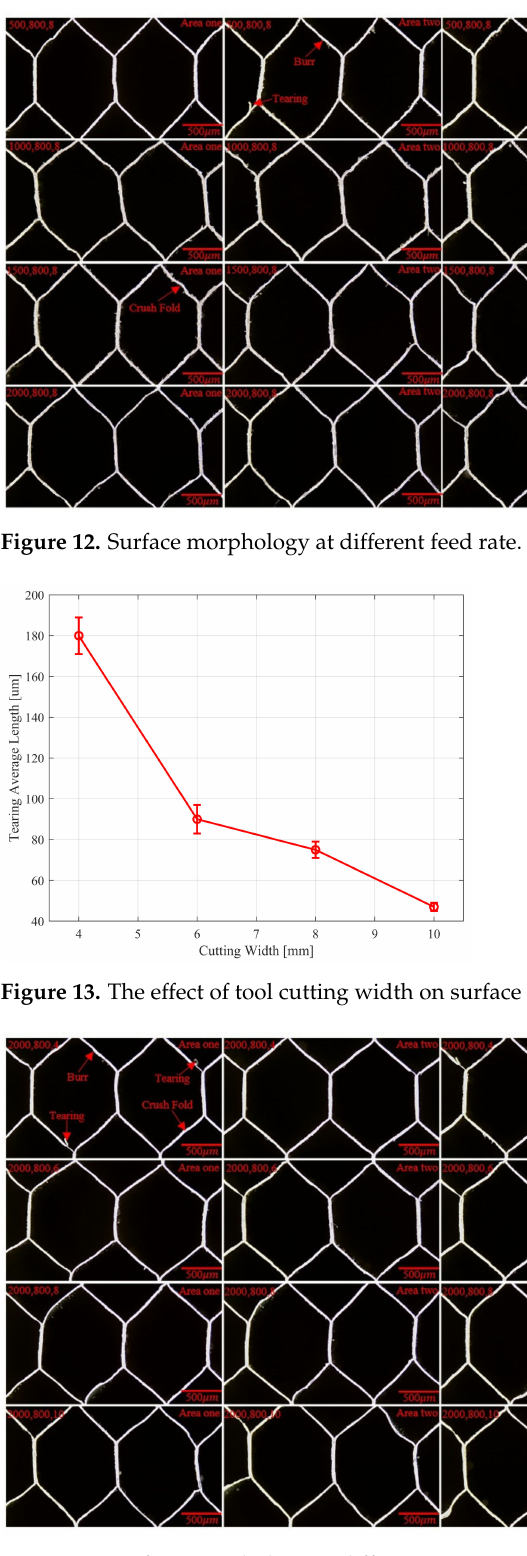
Figure 14. Surface morphology at different cutting